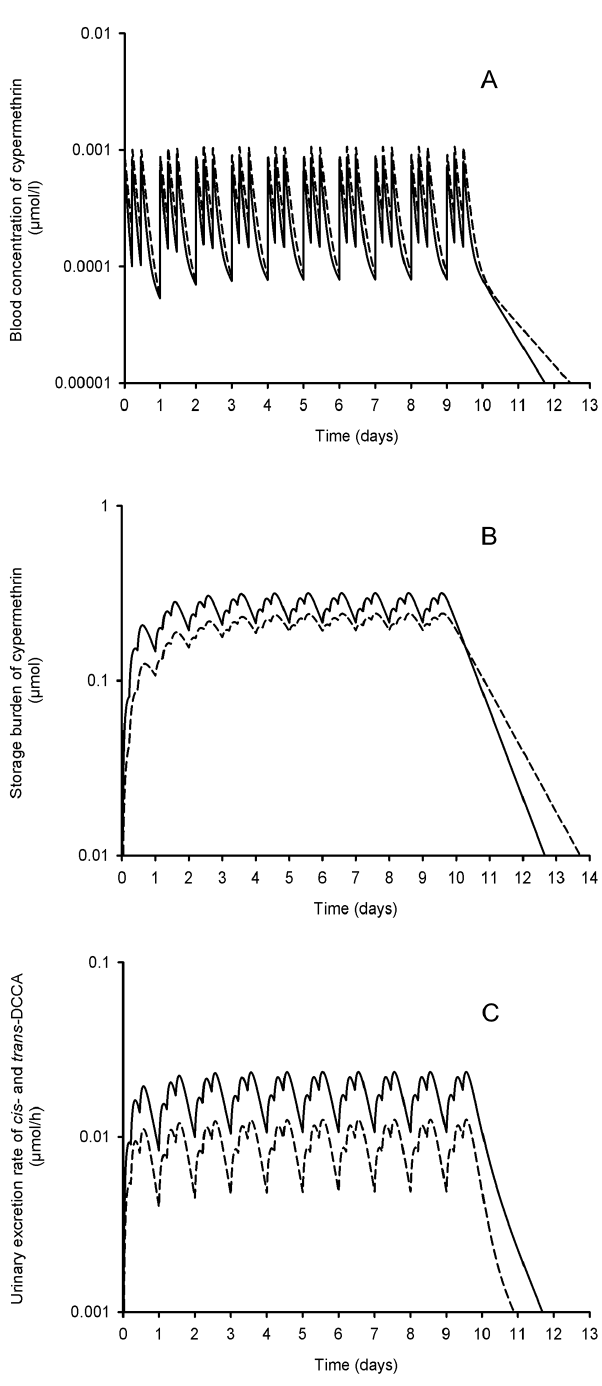
Figure 10. Model simulations of cypermethrin and DCCA in blood, storage tissues and urine following repeated oral exposure. Model simulations (lines) of the time courses of cyper- methrin in blood (B(t)) (A) and storage tissues (S(t)) (B) as well as trans - and cis -DCCA in urine (U(t); solid and dotted lines, respectively) (C) following a repeated oral exposure, 3 times per day (at 7:30 am, 12: 30 am and 6:30 pm), during 10 consecutive days to a dose corresponding to 1/10 of the dose administered by Woollen et al. (1992) (0.33